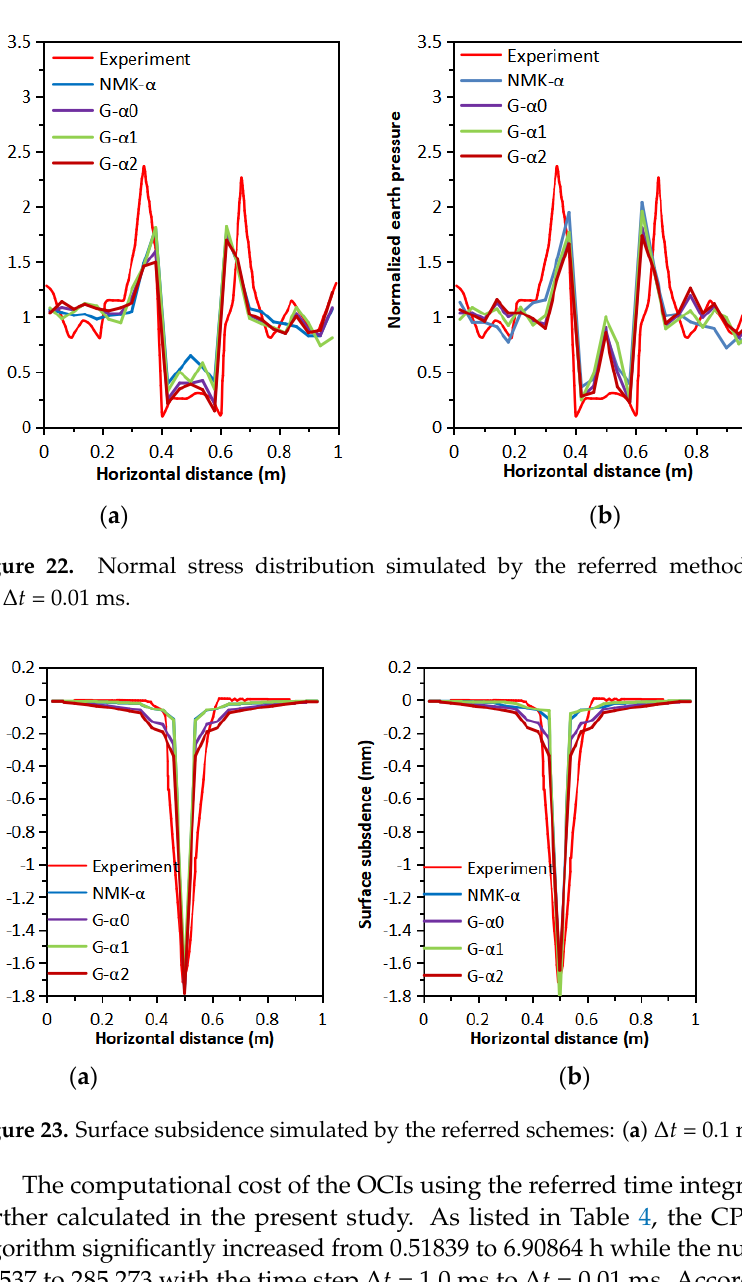
Table 4. Comparisons of CPU cost and OCIs between the referred schemes. Time Integration